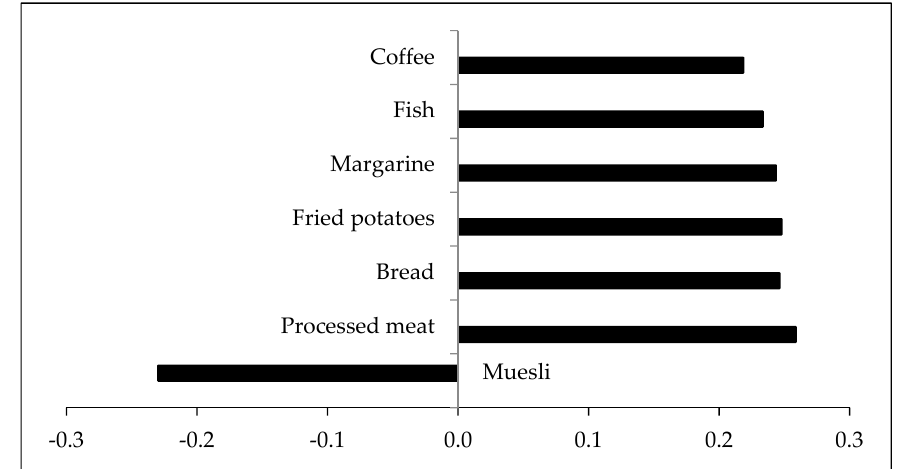
Figure 3. Factor loadings of all 53 food groups in first dietary pattern score. Factor loadings are correlations between food groups and the dietary pattern score. Food groups with factor loadings >0.2 were chosen for the dietary pattern.